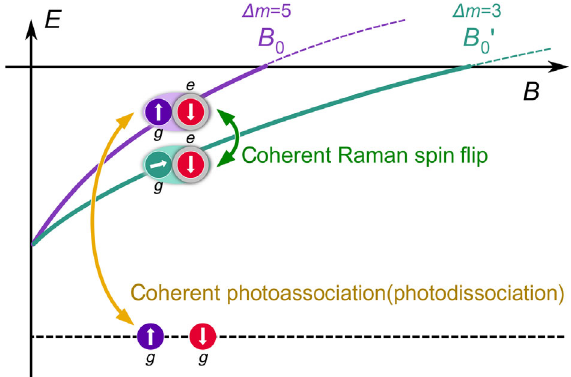
FIG. 2. Sketch of the processes considered in this work and corresponding energy levels. The solid lines show the binding energies for 173 Yb j e i – j g i atom pairs with different values of Δ m (difference between the nuclear-spin projection quantum num- bers) and B 0 ( B 0 0 ) denotes the position of the OFR center. The arrows show the different laser transitions used in the experiment for molecular production(and dissociation) and control of the internal